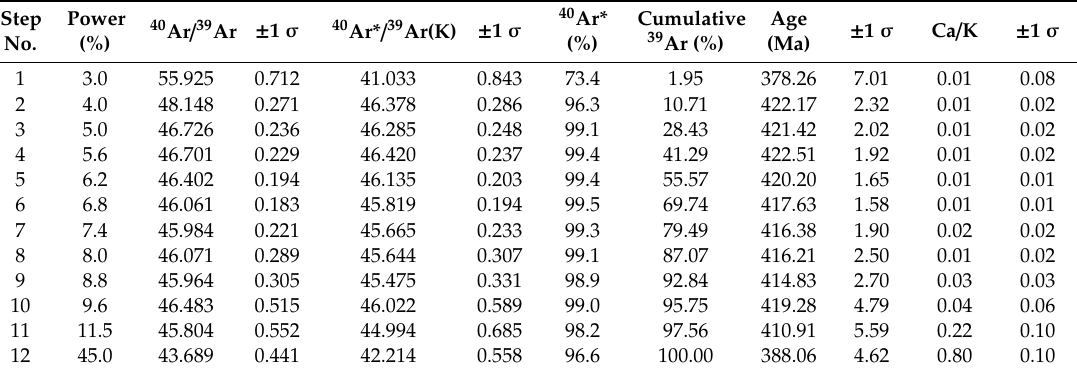
Table 9. Argon step heating data of muscovite from sample LG-78-4-143.5, J value = 0.005702 ± 0.000017 (1 σ ), Plateau Date = 422.4 ± 1.7 Ma (2 σ ) (MSWD = 1.3, 67.8% 39 Ar), Plateau Segment Date = 418.4 ± 2.6